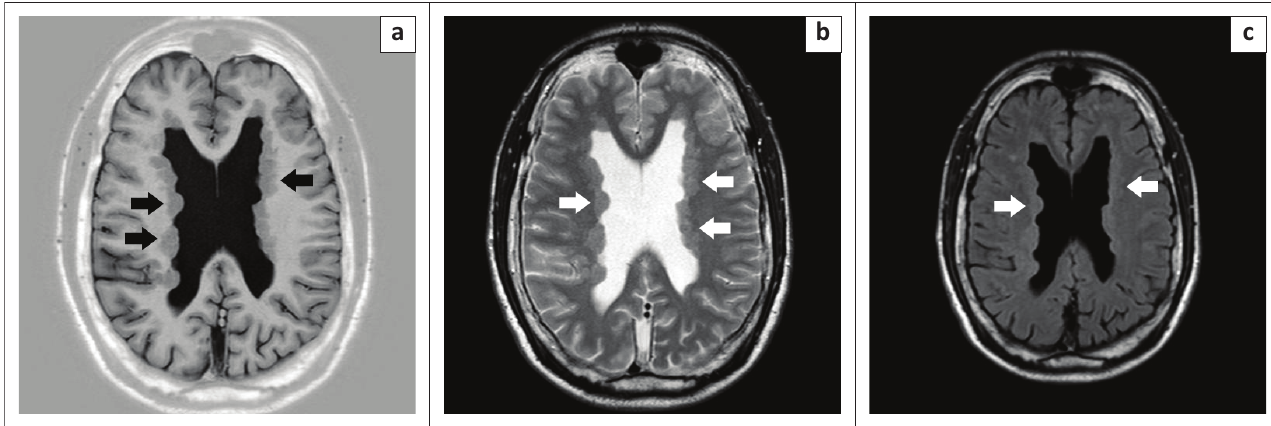
FIGURE 1: MRI scan sections of the patient’s brain indicating the presence of GMH. (a) A T1W IR SENSE axial section of the brain with arrows indicating bilateral and asymmetrical PNH with heterotopic grey matter stretching all along the ventricular walls, even present anterior to the anterior horns. Note that the shade of grey is the same as that of the cortical grey matter (the same signal intensity), which confirms that it is grey matter – the pathognomonic finding in GMH. (b) The arrows point towards the PNH where the typical nodular appearance of the heterotopic grey matter can be seen on this T2W TSE SENSE axial section of the brain. (c) On this T2W CLEAR SENSE GAD enhanced axial section of the brain, one can see how the subependymal nodules cause bulging of the ventricular walls, as pointed out by the arrows. GMH – grey matter heterotopia; T1W – Tau 1 weighted; T2W – Tau 2 weighted; FLAIR – fluid-attenuated inversion recovery; IR – inversion recovery; FFE – fast field echo; SENSE – sensitivity encoding; TSE – turbo spin echo; CLEAR – constant level appearance; GAD – gadolinium; PNH – periventricular nodular